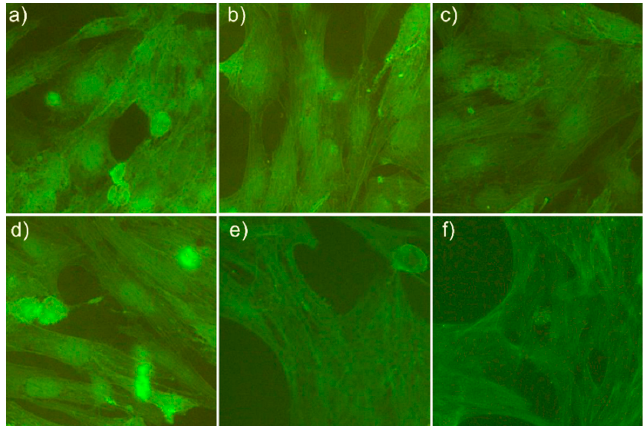
Figure 14. Fluorescence micrographs of osteoblasts cells plated on Ti discs used as control ( a , d ) and Ag: HAp-S1 and Ag: HAp-S2 composite layers at the two time intervals T0 (Ag:HAp-S1_T0 ( b ) and Ag:HAp-S2_T0 ( c )) and T6 (Ag:HAp-S1_T6 ( e ) and Ag:HAp-S2_T6 ( f )) after 24 h of incubation.